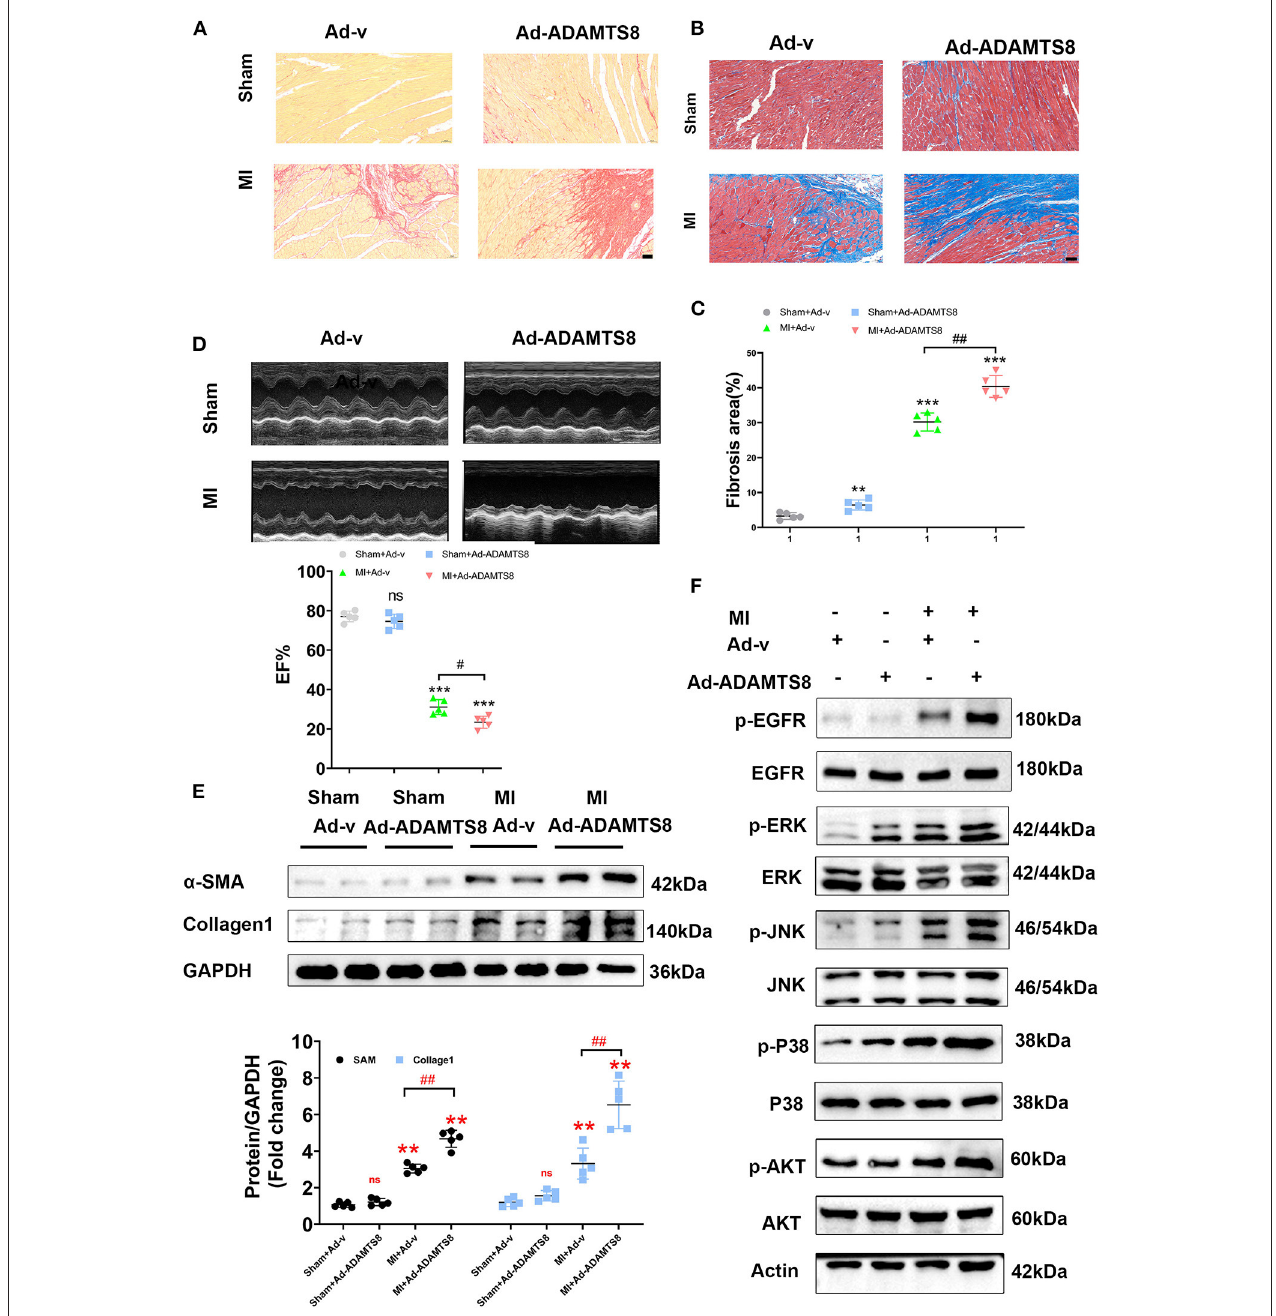
FIGURE 8 | ADAMTS8 overexpression promoted cardiac fibrosis and impaired cardiac function in vivo . (A–C) Representative pictures from Sirius red and Masson staining and quantitative analysis of interstitial fibrotic area in the infarct border zone of Ad-v Sham, Ad-ADAMTS8 Sham, Ad-v MI, and Ad-ADAMTS8 MI rats (scale bar = 50 µ m). (D) Representative M-mode images of Ad-v Sham, Ad-ADAMTS8 Sham, Ad-v MI, and Ad-ADAMTS8 MI groups; EF was quantified via echocardiography. (E) Collage1 and α -SMA expression levels were quantified by western blotting. (F) Activation of the EGFR, MAPK, and AKT signaling pathways of a rat model of MI following adenovirus injection was detected via western blotting in vivo . Data were presented as mean ± SEM. ** P < 0.01, *** P < 0.001, # P < 0.05, ## P < 0.01, and NS indicates no significance between the two indicated groups.